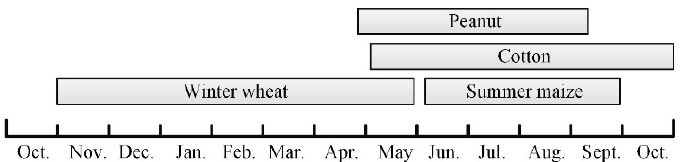
Figure 4. Phenology calendar of principal crops in the reference area.